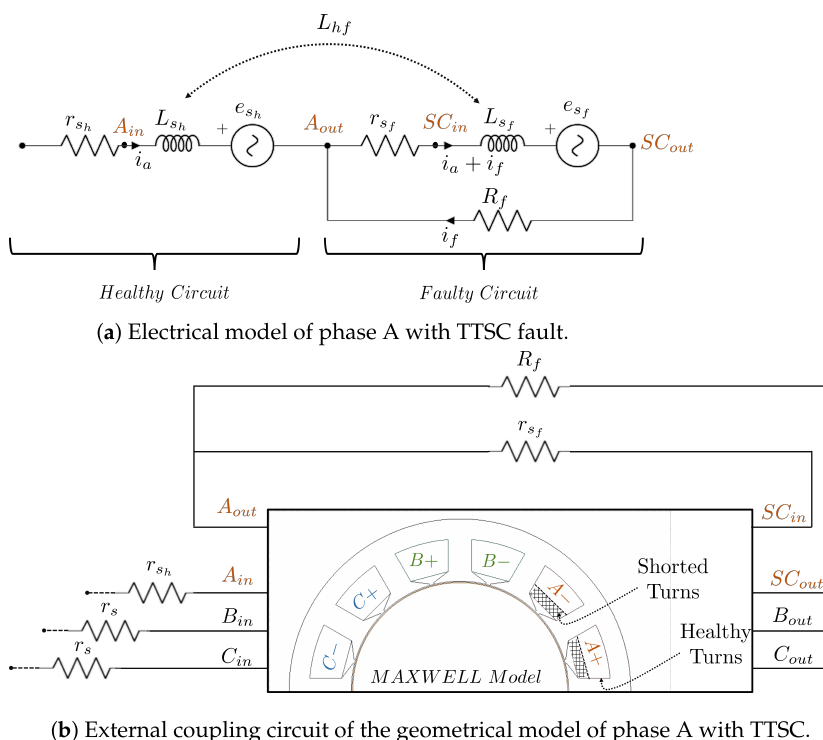
Figure 5. TTSC fault simulation in the PMSM